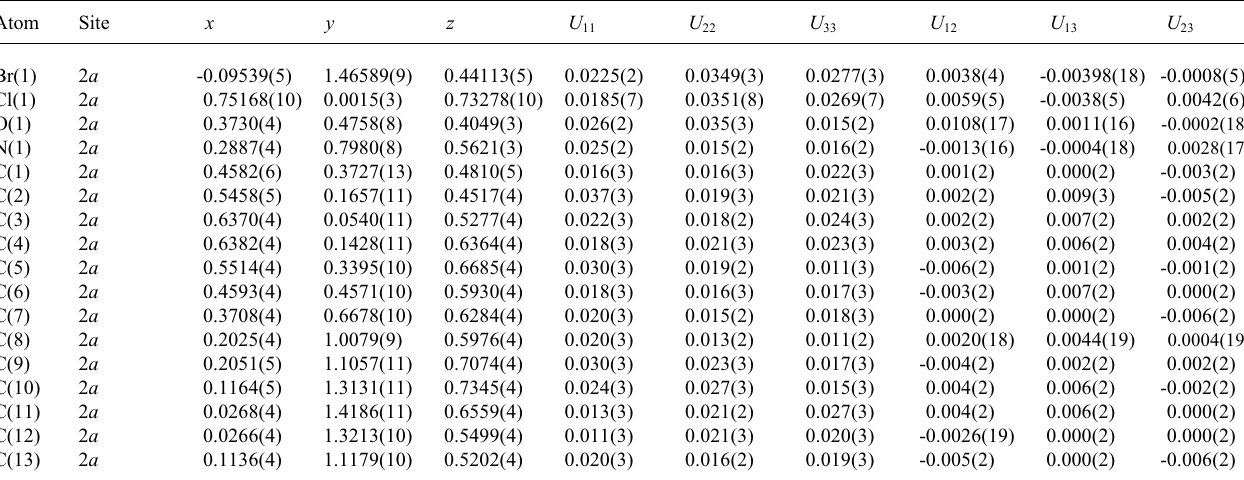
Table 3. Atomic coordinates and displacement parameters (in Å 2 )